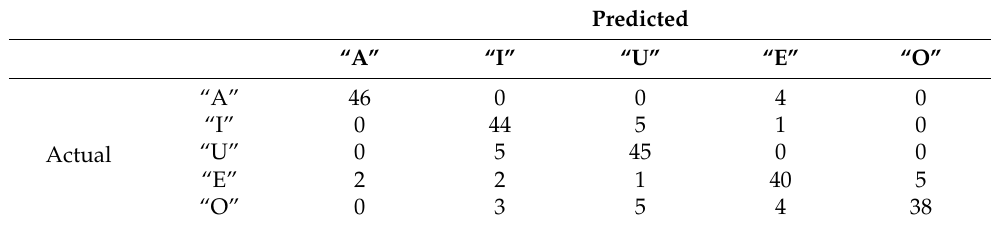
Table 9. Confusion matrix using test data (male-only).